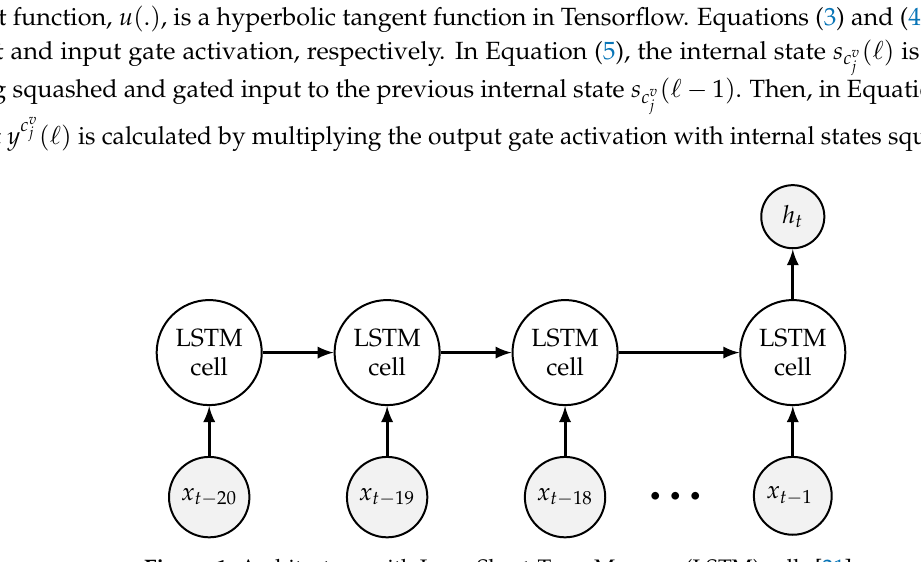
Figure 1. Architecture with Long Short-Term Memory (LSTM) cells